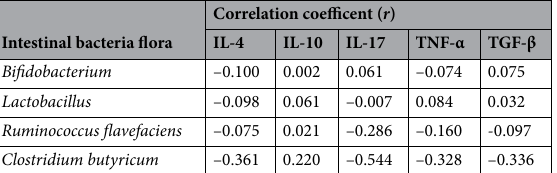
Table 2. Correlation coefficient of the number of intestinal bacteria flora and the serum inflammatory factor